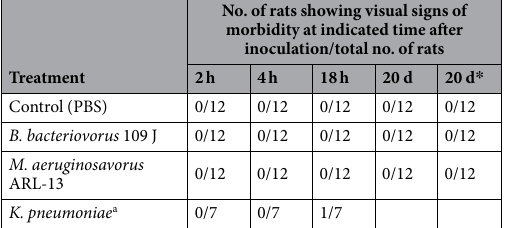
No. of rats showing visual signs of morbidity at indicated time after